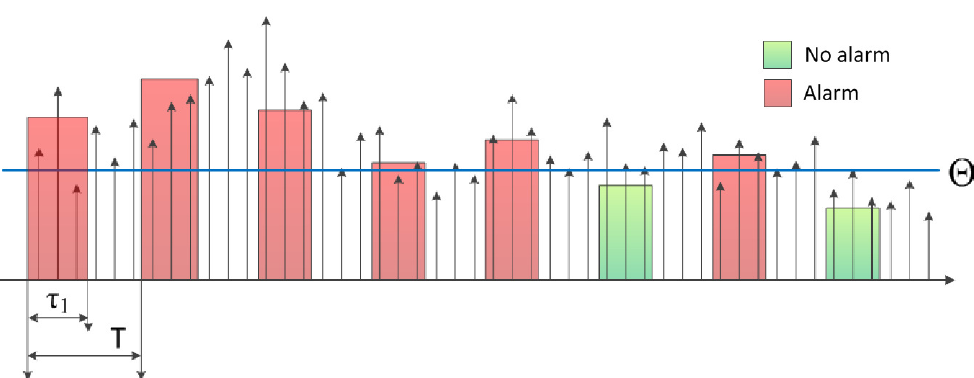
Figure 2. Operation of the Block-wise Autocovariance-based Algorithm (BAC) algorithm. Arrows represent acceleration data. Rectangles show segments where sampling and processing is performed; red and green rectangles represent segments where the computed autocovariance is higher and lower than the threshold,